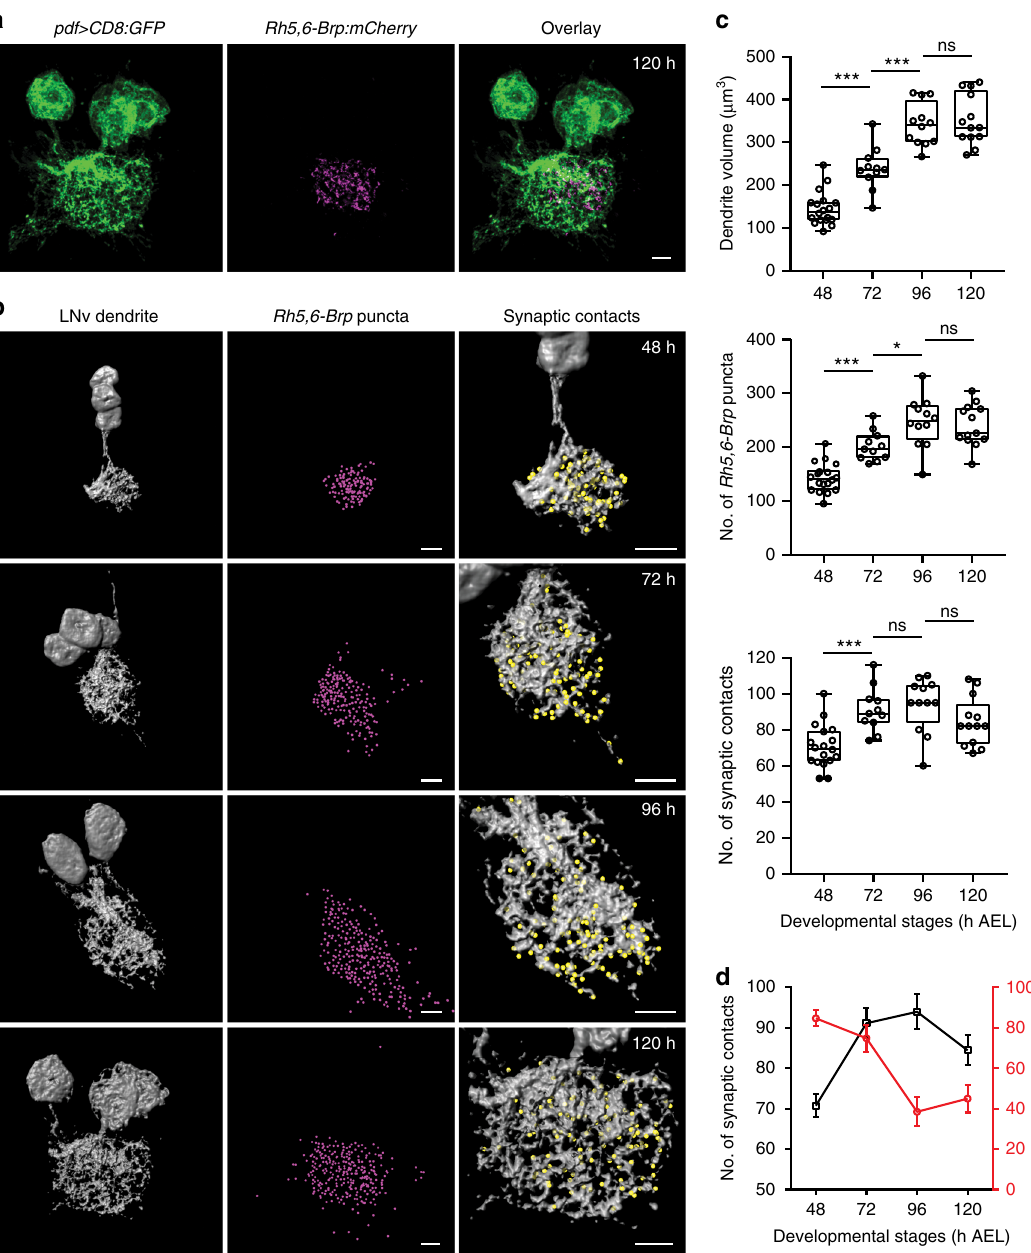
Fig. 3 Temporal coupling of dendrite dynamics with synaptogenesis in LNvs. a Representative projected confocal images of the LNv dendrite (green) co- labeled with Rh5,6-Brp:mCherry (magenta). Scale bar, 5 μ m. b The LNv dendrite volume (gray), the number of presynaptic terminals from the BN in the LON region ( Rh5,6-Brp puncta, magenta spots) and the number of Brp puncta contacting the LNv dendrites (synaptic contacts, yellow spots) were analyzed using 3D reconstructions. Representative images for samples collected at the indicated time points are shown. Scale bar, 5 μ m. c LNv dendrite volume (Top) increases during development until 96 h; Rh5,6-Brp puncta (Middle) shows similar trend and plateaus at 96 h; The number of synaptic contacts (Bottom) increases signi fi cantly from 48 to 72 h, then remains steady. n = 18, 11, 12, and 13 for 48, 72, 96, and 120 h, respectively. Statistical signi fi cance was assessed by one-way ANOVA followed by Tukey ’ s post hoc test. Volume (Top), ANOVA: F 3, 50 = 60.19, P < 0.001; Tukey ’ s: P < 0.001, 48 vs 72 h and 72 vs 96 h; P = 0.949, 96 vs 120 h. Rh5,6-Brp puncta (Middle), ANOVA: F 3, 50 = 30.03, P < 0.001; Tukey ’ s: P < 0.001, 48 vs 72 h; P = 0.015, 72 vs 96 h; P = 0.963, 96 vs 120 h. Synaptic contacts (Bottom), ANOVA: F = 9.465, P < 0.001; Tukey ’ s: P = 0.001, 48 vs 72 h; P = 0.955, 72 vs 96 h; P = 0.278, 96 3, 50 vs 120 h. Data are presented as box plot (box, 25 – 75%; center line, median) overlaid with dot plot (individual data points). ns, not signi fi cant; *P < 0.05, ***P < 0.001. d The number of synaptic contacts (black) reaches saturation at 72 h, coinciding with the peak of LNv dendrite dynamics (red). Trend lines were generated using data from Figs. 1c, 3c. Error bars represent We performed LNv-speci fi c in vivo transgenic RNAi screens formation (Supplementary Data 1). Larvae co-expressing mem- on a collection of RNAi lines targeting 134 genes, including brane-targeted GFP, a transgenic RNAi construct and Dicer2 cytoskeleton components and motor proteins, as well as signaling driven by Pdf-Gal4, were cultured under LD or LL conditions. molecules related to cytoskeleton remodeling and synapse From the same genotype, we characterized dendrite volume